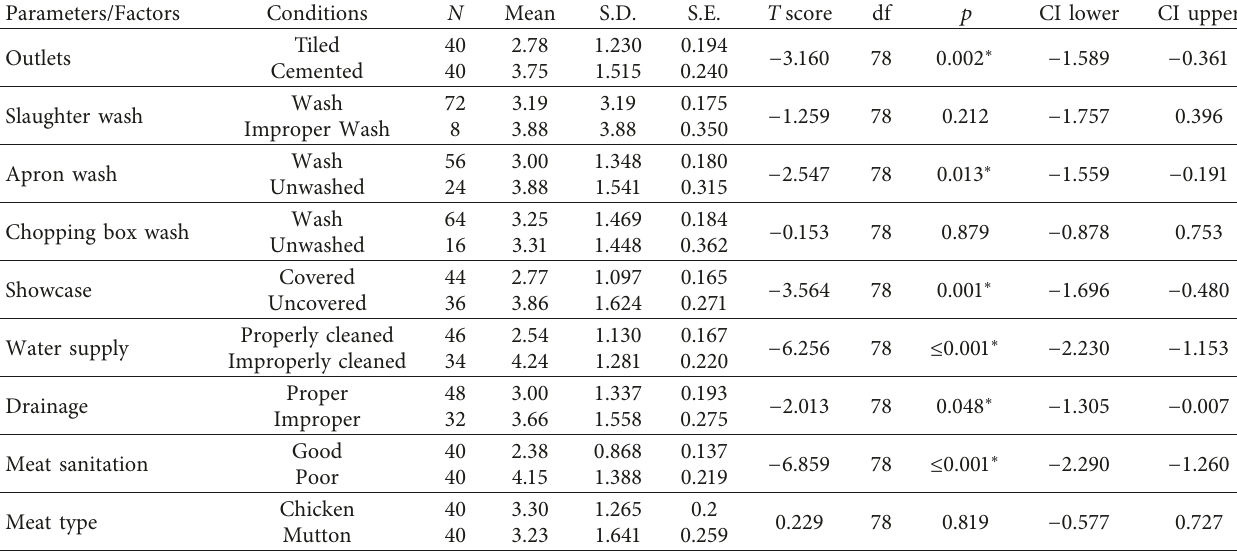
Table 10: Independent sample T -test of mean of different types of isolates in meat against several sanitation parameters and meat type.